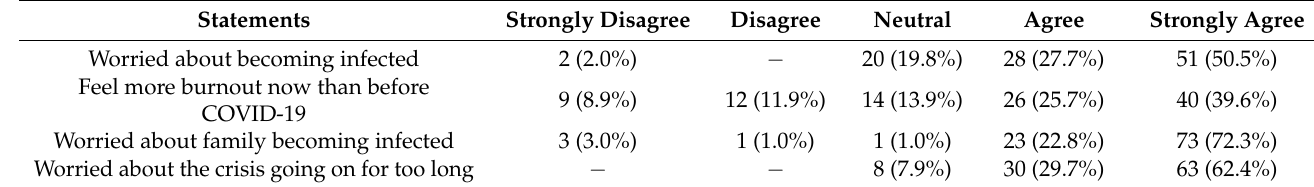
Table 2. Current attitudes toward COVID-19 among the study